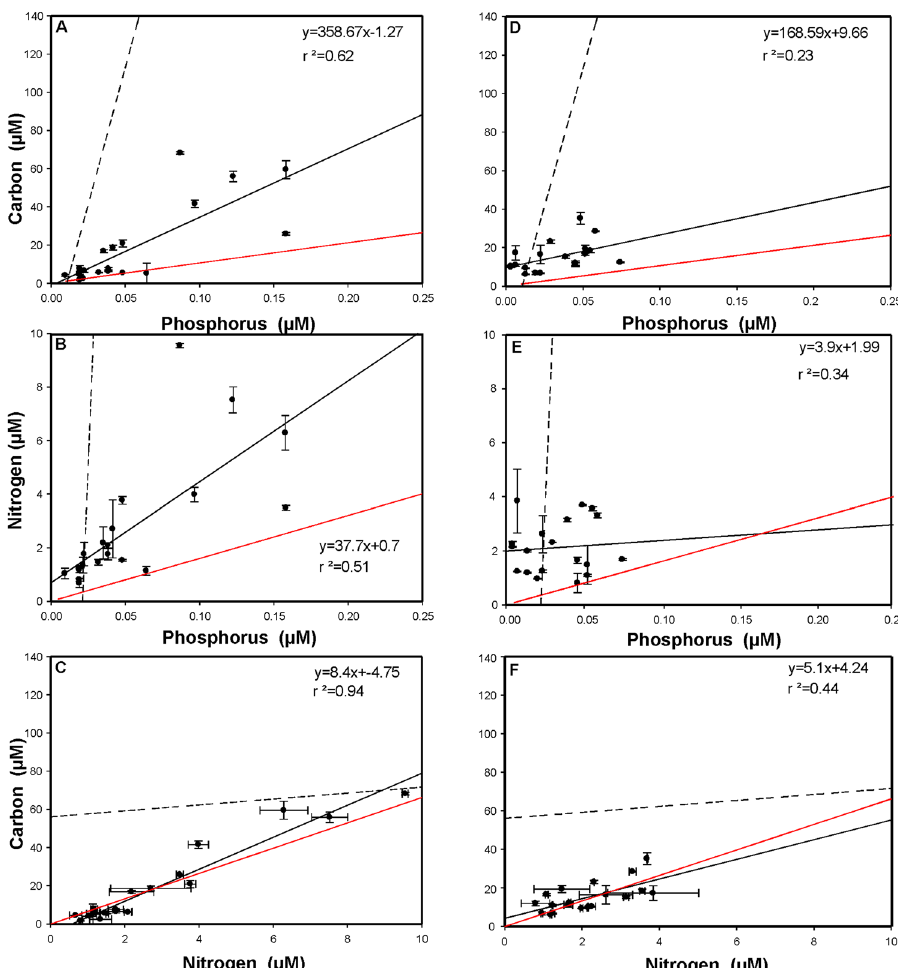
Figure 1. Regression analysis between the concentration of carbon, nitrogen, and phosphorus in the microbial size-fraction (0.7–1 µ m) in July ( A , B , C ) and in October ( D , E , F ). The red line represents the Redfield ratio of these elements, the continuous line represents the regression for the microbial size-fraction (with corresponding equation) and the dotted line that for the pooled dissolved